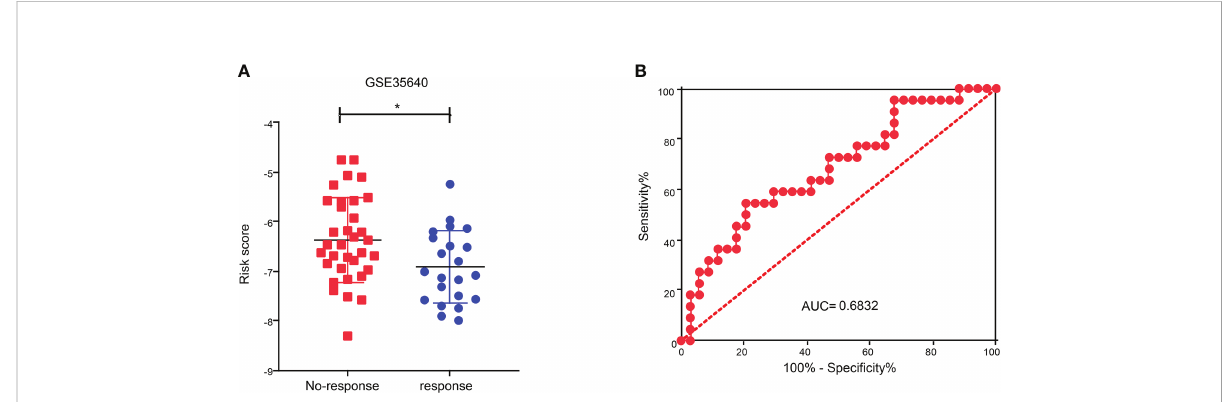
FIGURE 7 Relationship between CDIGPM and immunotherapy. (A) CDIGPM in patients who did not respond to immunotherapy is higher than it in patients who responded to immunotherapy. (B) ROC curve. (*p < 0.05). CDIGPM: CD8 + T cells-associated immune genes prognostic